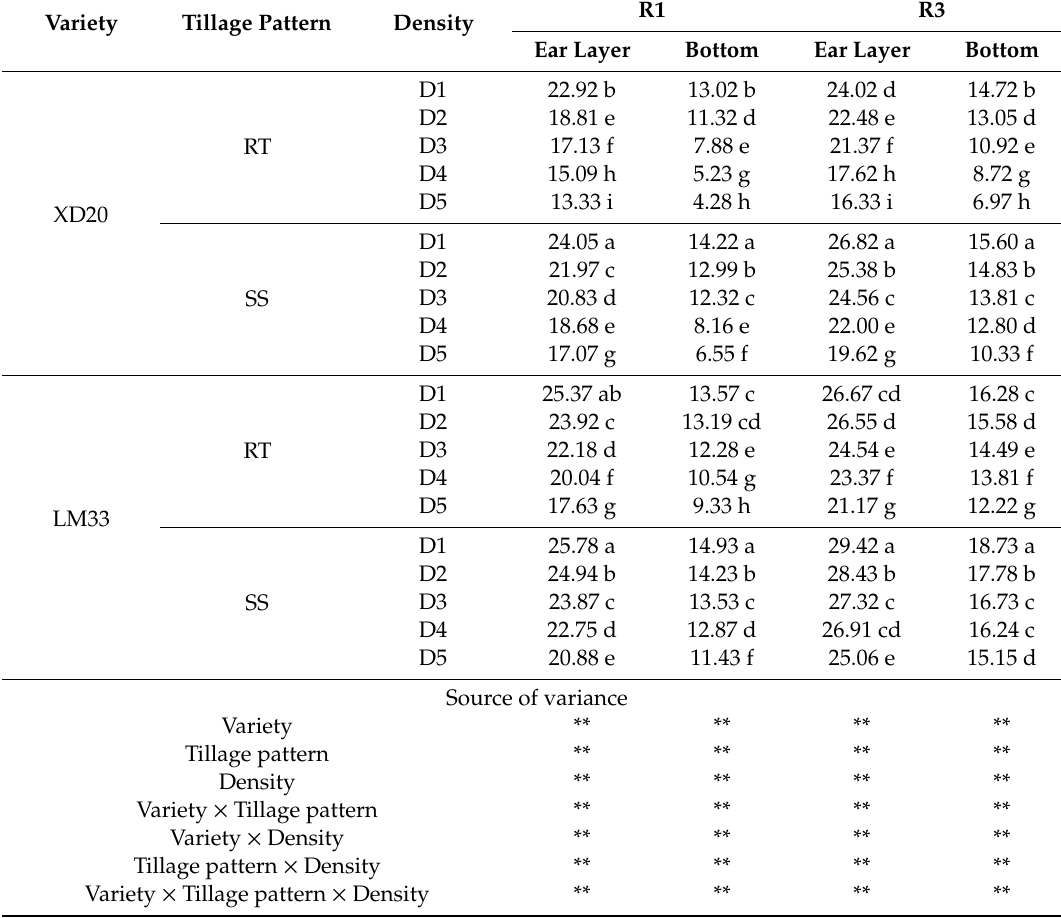
Table 4. Ear and bottom layer leaf light transmission percentage (LTP) of high-yielding spring maize under di ff erent tillage methods and planting